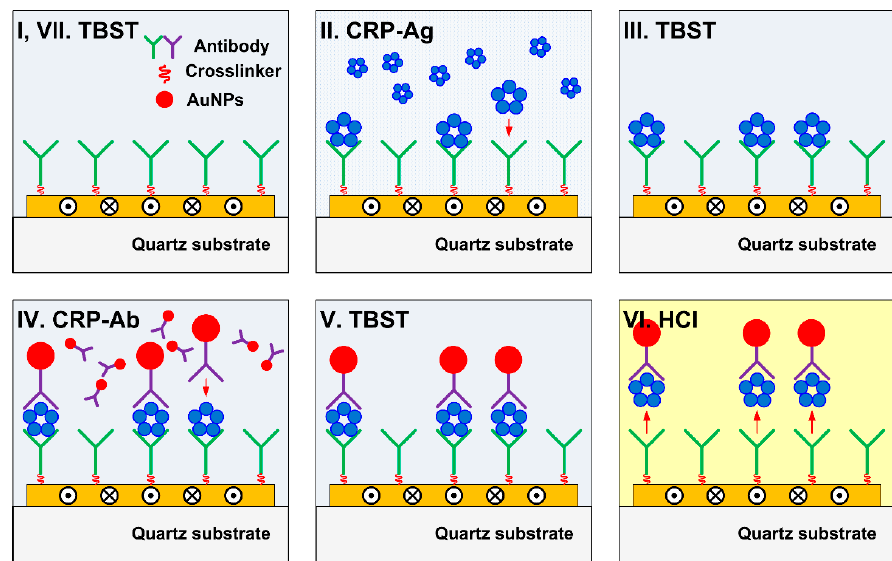
Figure 5. Surface condition in each measurement step. Table 3. Measurement process.